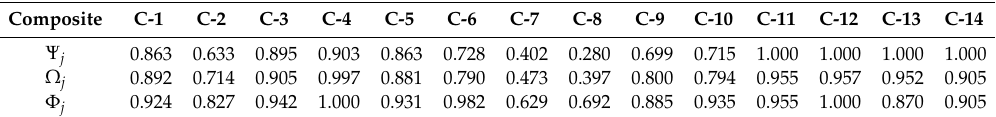
Table 5. The preference variation ( Ψ j ), deviation related to the preference variation ( Ω j ), and the overall preference value ( Φ j ).